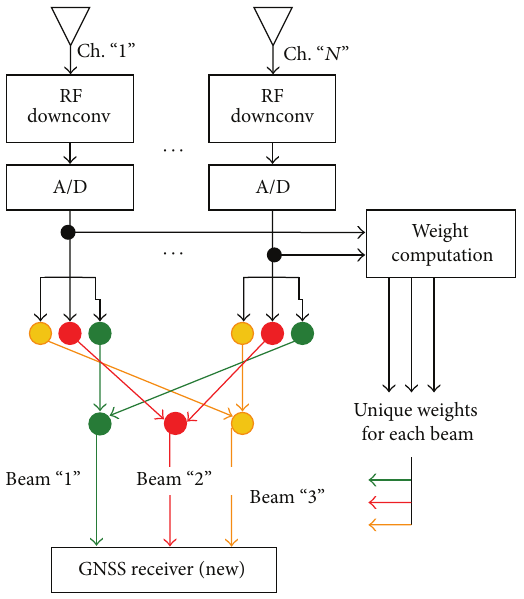
Figure 2: Multiple-output beam-steering antenna block